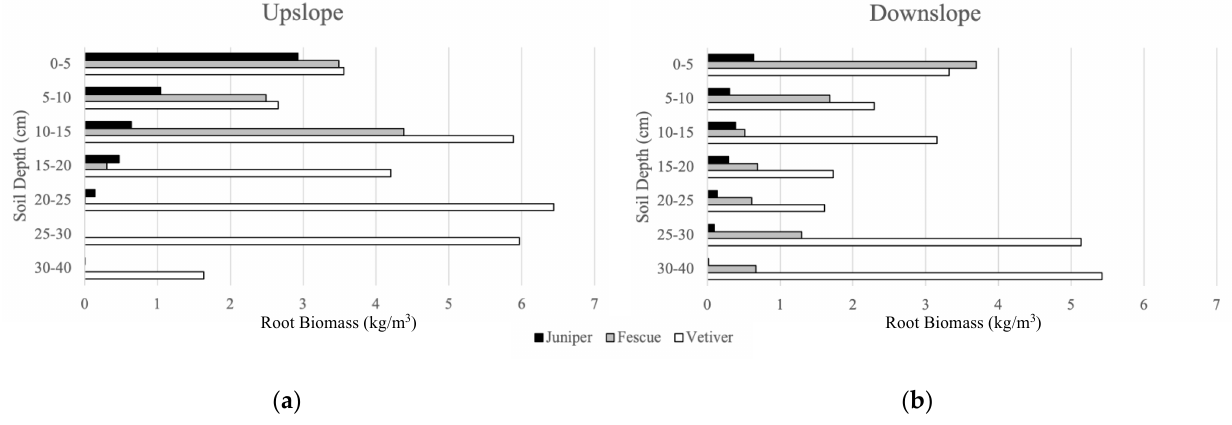
Figure 11. Root biomass by layer for three species in the ( a ) upslope core; and ( b ) downslope core. Table 3. Root biomass by species in the top 40 cm of soil for the upslope core, the downslope core, and the mean of the two cores.